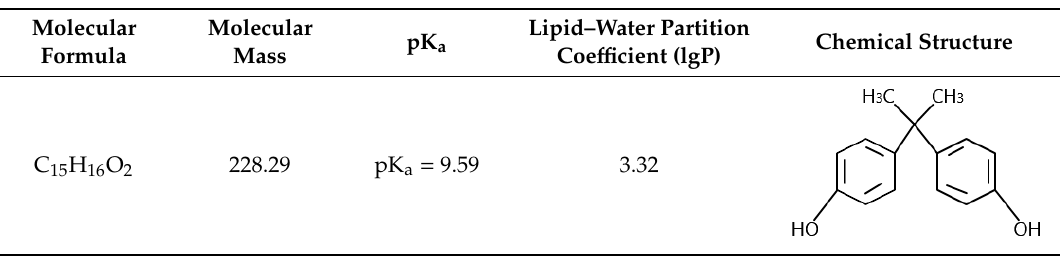
Table 1. Characteristics of bisphenol A (BPA).